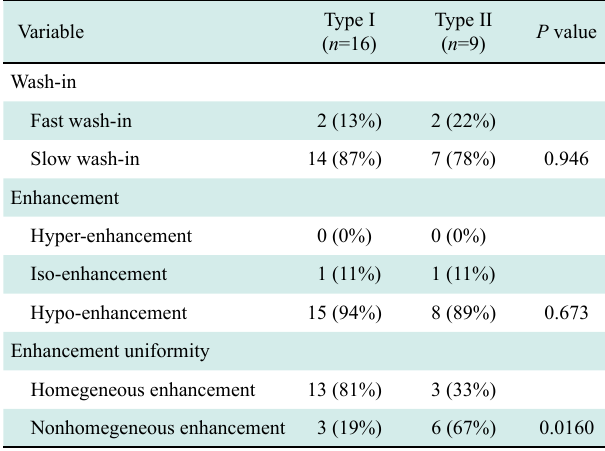
Table 3 Characteristics of PRCC types I and II using contrast-enhanced